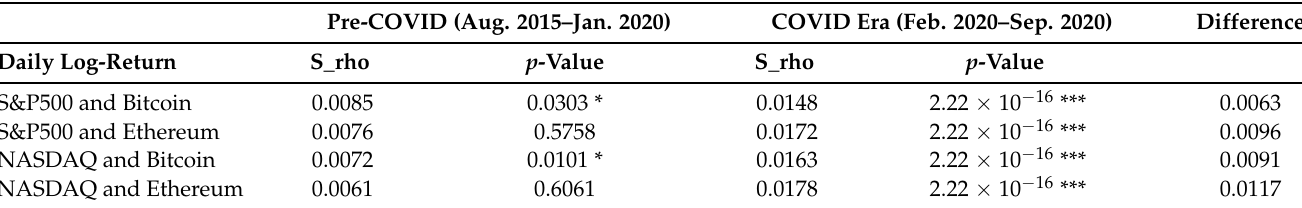
Table 5. Independence